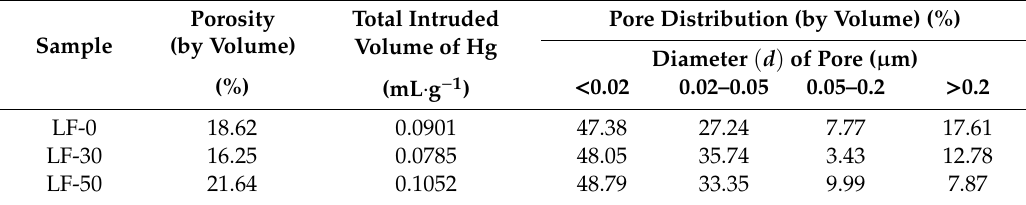
Figure 4. Pore distribution of cement matrix in LF-0, LF-30, and LF-50. Table 3. Pore structure parameters of the mortar tested by MIP.